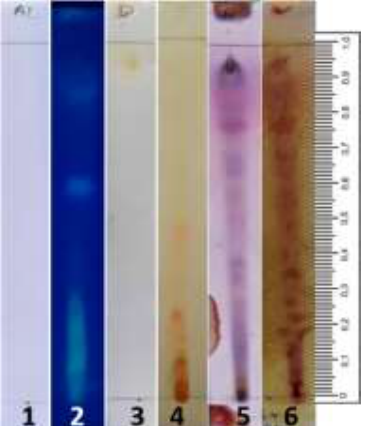
Figure 4. Phytochemical analysis of ethyl acetate extract from broth medium of E. linearis detected by dyeing reagents. Silica gel 60 F 254 was used as the stationary phase with mobile phase chloroform:ethyl acetate (1:1). Dyeing reagent 1: AlCl 3 visible light ; 2: AlCl 3 at UV 366 ; 3: Dragendorff ; 4: FeCl 3 ; 5: Anisaldehyde-sulfuric acid ; 6: Vanillin sulfuric